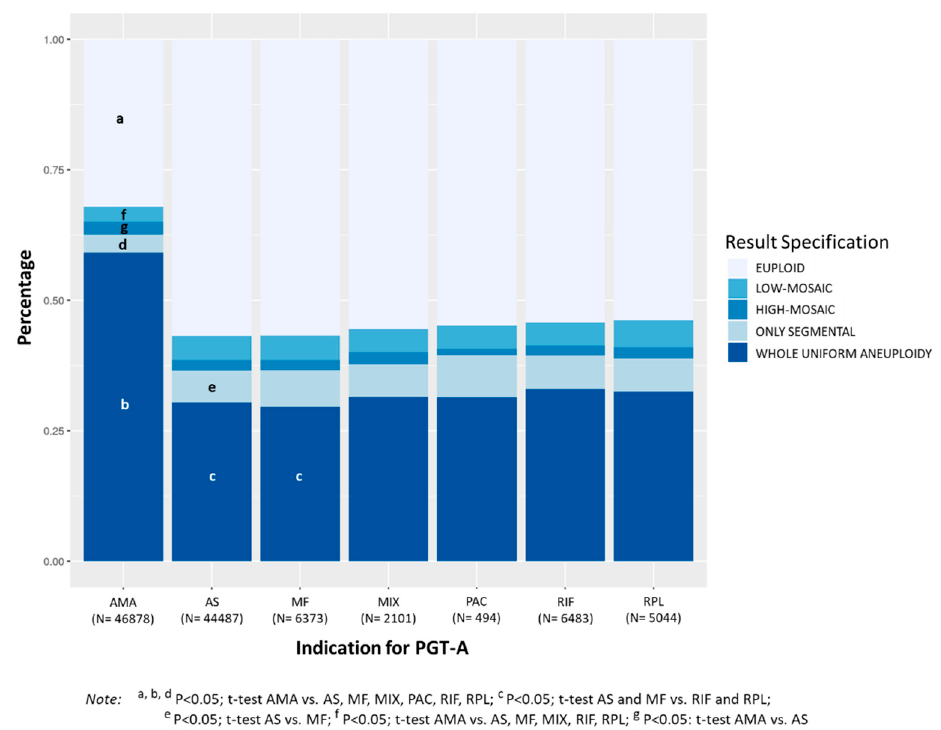
Figure 5. Distribution of the percentages of chromosomal abnormalities in TE biopsies (euploid, low-mosaic, high-mosaic, only segmental, and whole uniform aneuploidy) according to the indication for PGT-A (AMA: advanced maternal age ≥ 37 years; AS: aneuploidy screening; MF: male factor infertility; MIX: mixed causes; PAC: previous aneuploid conception; RIF: repetitive implantation failure; RPL: recurrent pregnancy loss). Female age was < 37 years in AS, MF, MIX, PAC, RIF, and RPL groups. The mean number of embryos biopsied (SD) per case was 4.4 (3.4) for AMA indication, 6.1 (6.6) for AS, 6.0 (3.7) for MF, 5.2